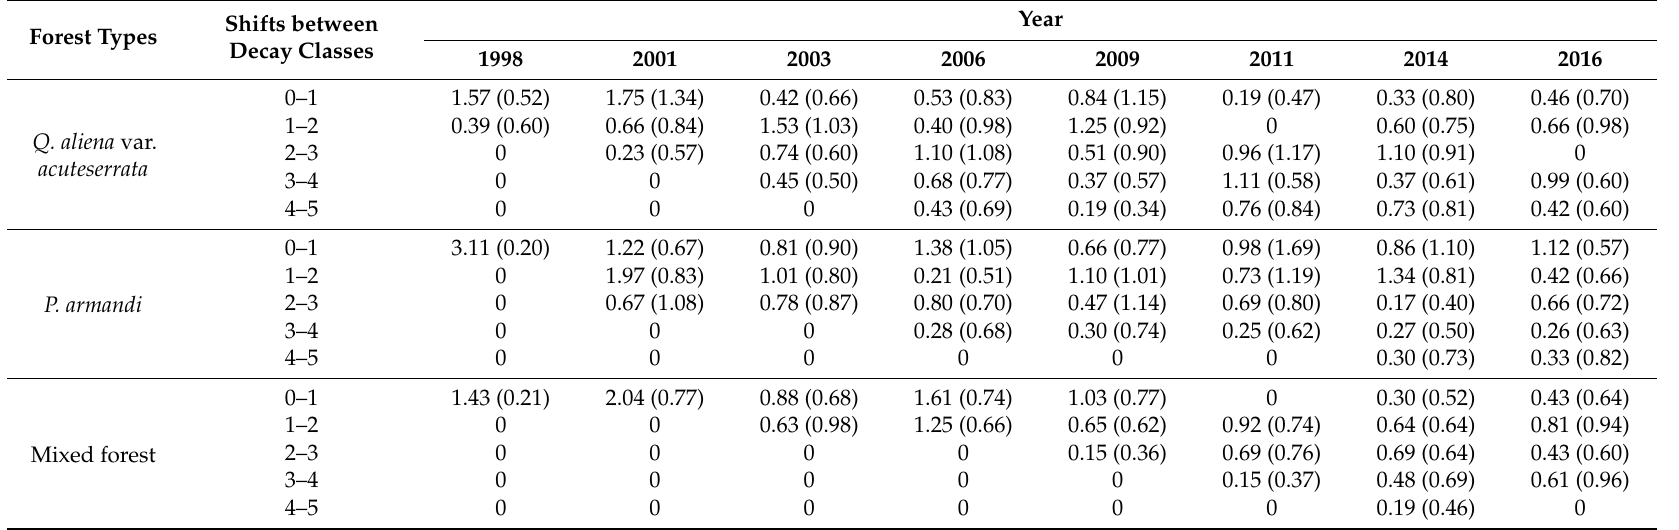
Table 5. The shifts in CWD mass (Mg · ha − 1 ) between decay classes at the nine tree censuses during 1996–2016 for the three forest types in the Huoditang Experimental Forest Farm in the Qinling Mountains